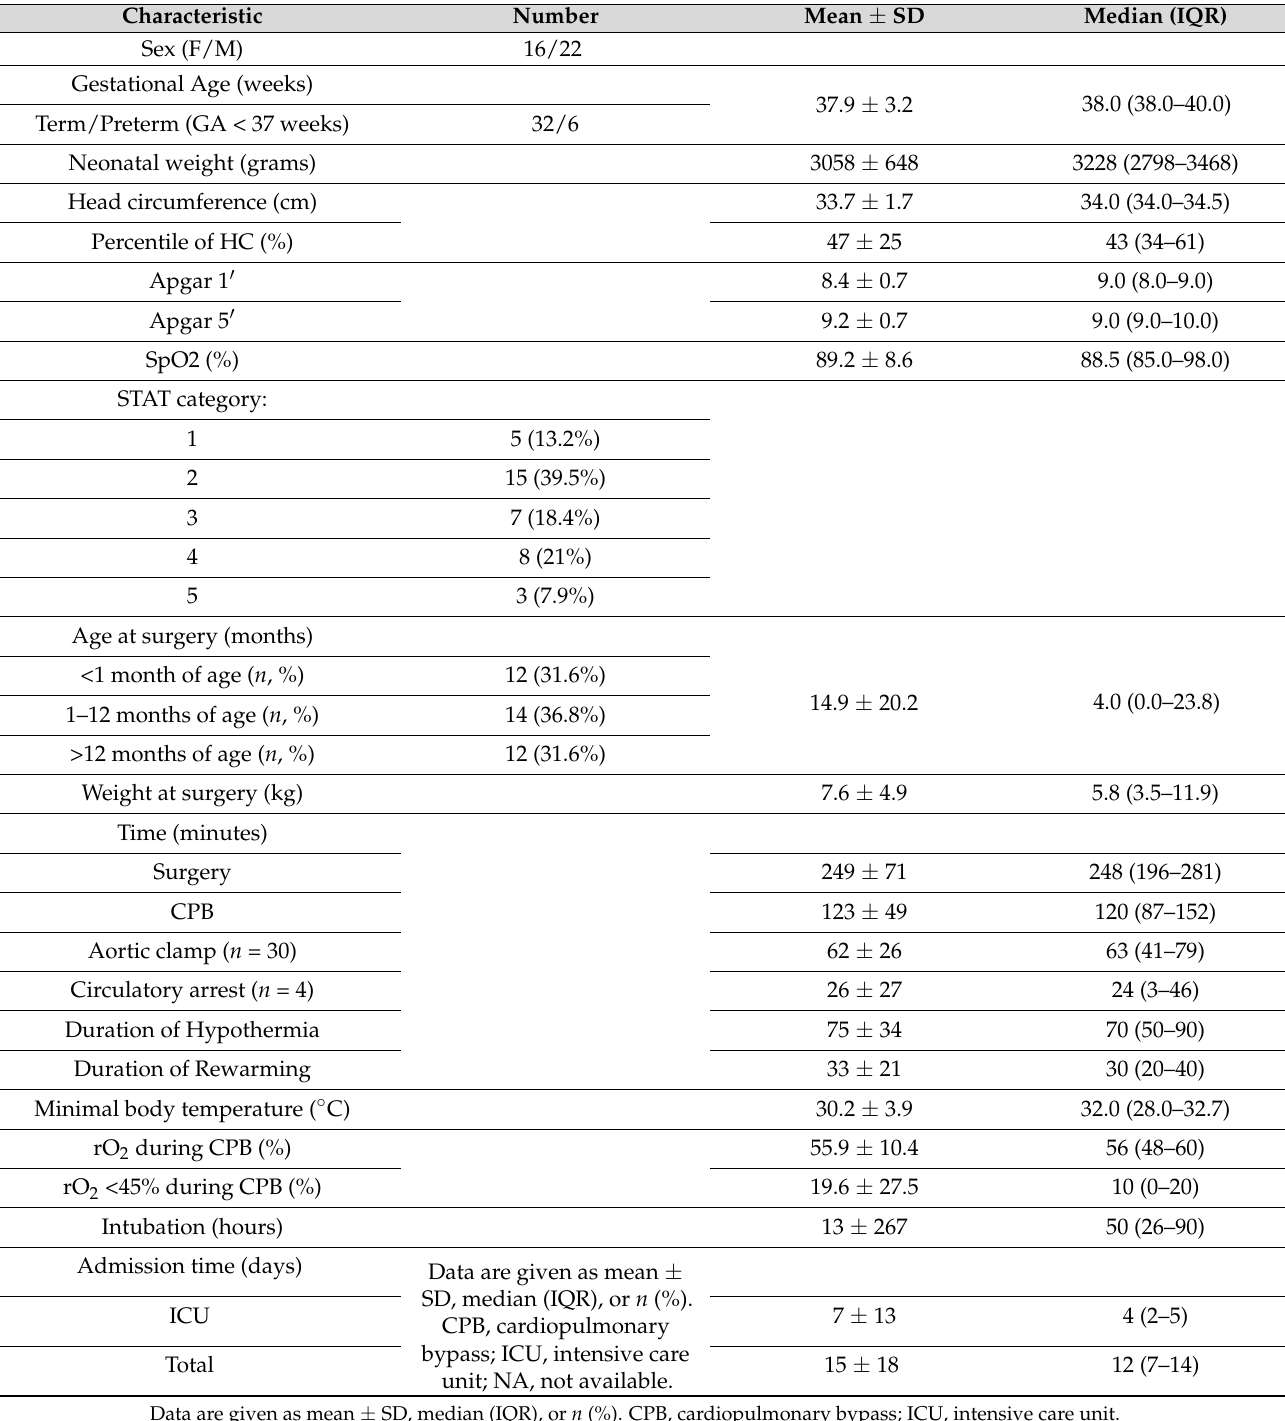
Table 1. Clinical and surgical